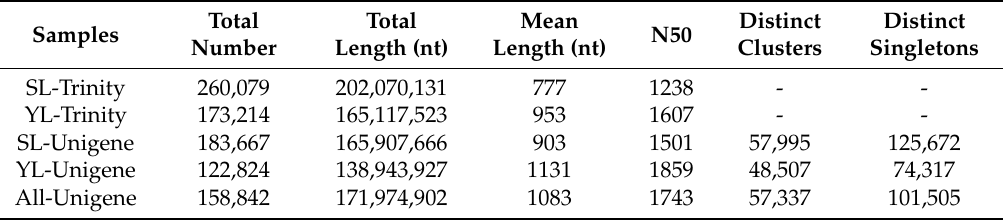
Table 1. Statistical analysis of de novo assembly of L. macranthoides